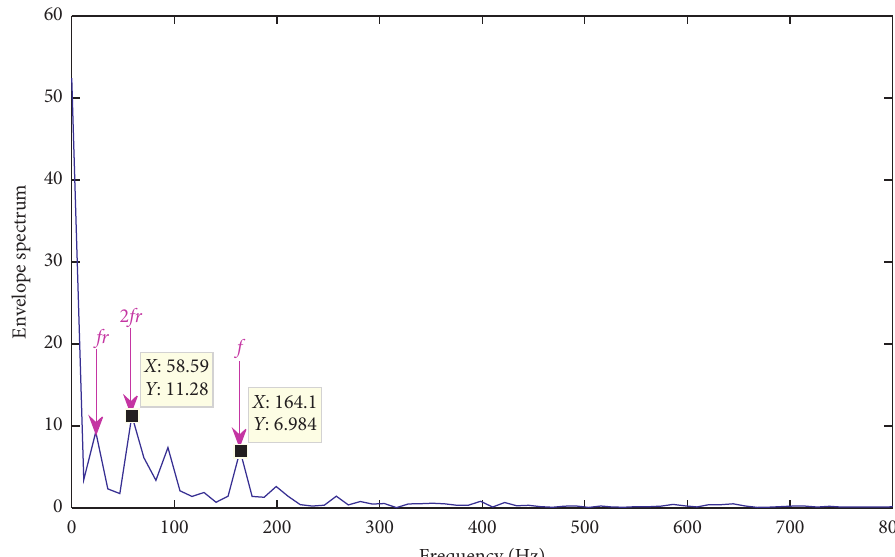
Figure 13: Envelope spectrum of effective mode extracted based on the maximum kurtosis.